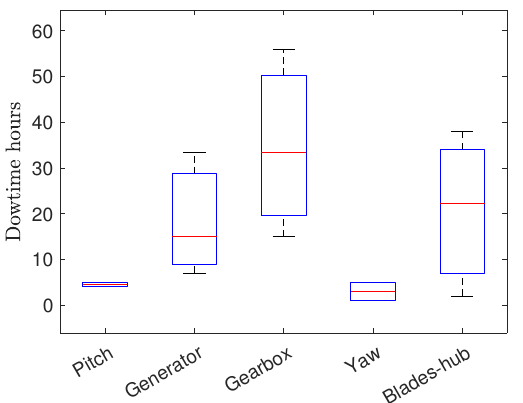
Figure 11. Box plot of downtime of components with higher failure rates for HAWT offshore wind farms. Data from Dinwoodie and McMillan, Carroll et al. and Dao et al.